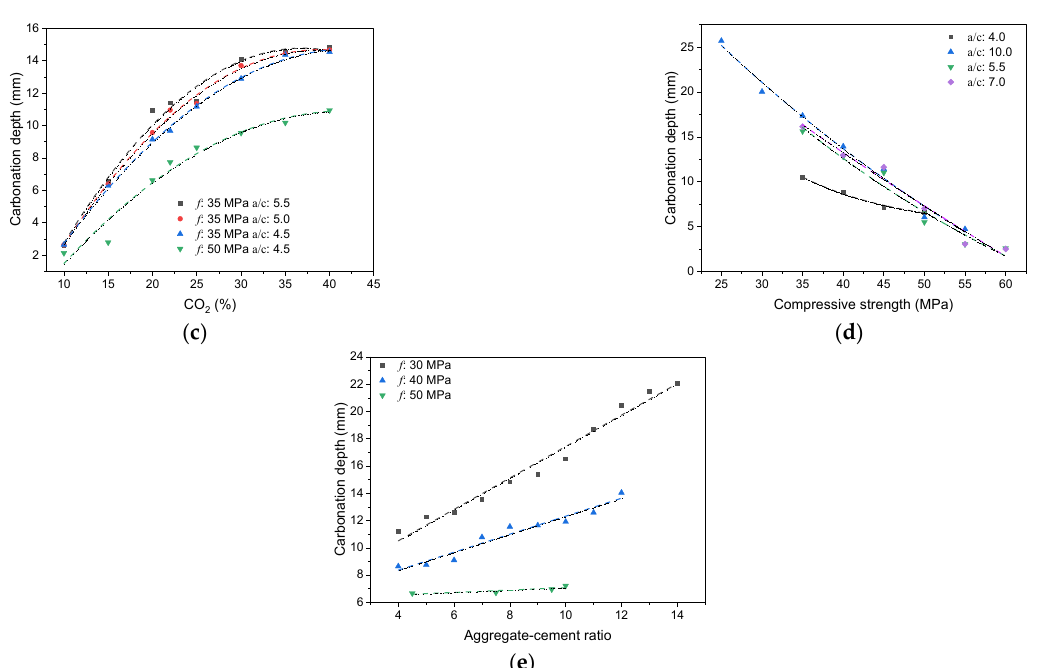
Figure 8. Relationship between carbonation depth and factors contained in the ML model: ( a ) the relationship between carbonation depth and relative humidity; ( b ) the relationship between carbonation depth and temperature; ( c ) the relationship between carbonation depth and CO 2 concentration; ( d ) the relationship between carbonation depth and compressive strength; ( e ) the relationship between carbonation depth and aggregate–cement ratio.